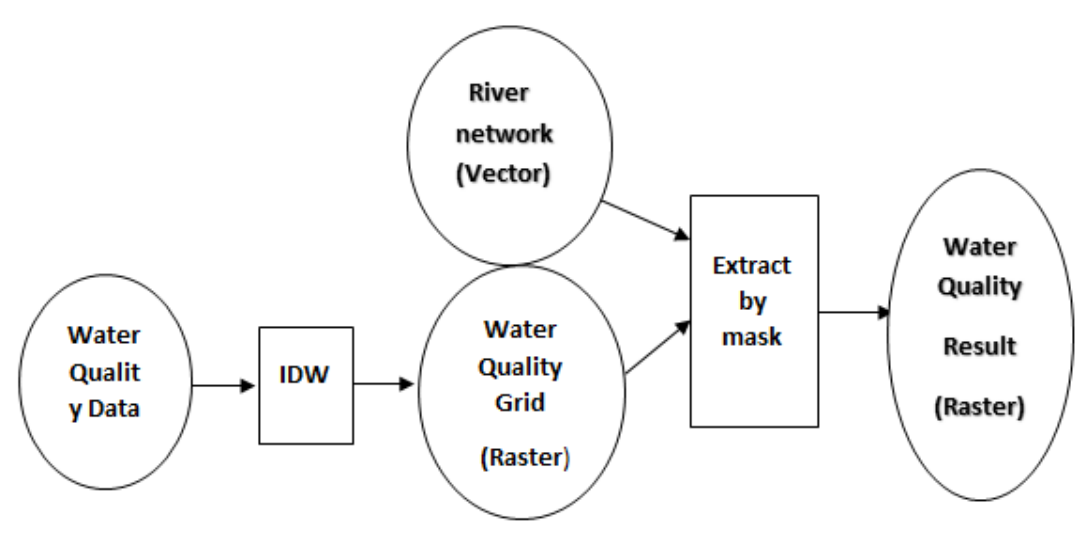
Fig.3 : Diagram of IDW mapping procedure in ArcGIS 10.4.